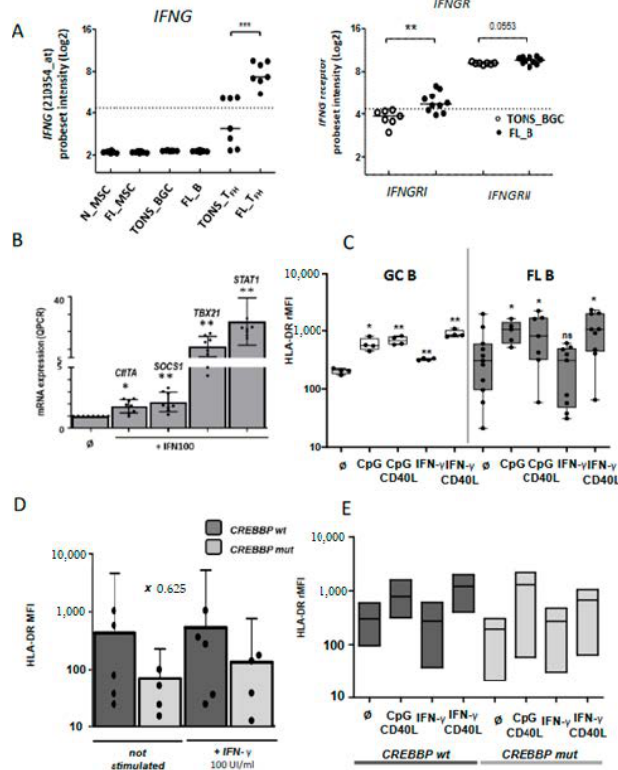
Figure 5. IFN- γ pathway in malignant B cells: ( A ) Up-regulation of IFNG (left panel) and IFNGR (right panel) mRNA expression on normal and FL subpopulations. ( B ) mRNA expression by qRT-PCR of IFN- γ -target genes ( CIITA, SOCS1, TBX21 and STAT1 ) in purified FL B cells stimulated or not ( Ǿ ) by IFN- γ 100 UI / mL (IFN100) for 24 h. ( C ) HLA-DR cell-surface expression on normal GC B cells (left panel) or FL B cells (right panel) cultivated for 24 h with CPG or IFN- γ , with or without CD40L stimulation, and according to CREBBP mutation. ( D and E ) rMFI: ratio of mean fluorescence intensity, wt: wild type, mut: mutation; Bars: mean. ns non-significant, * p < 0.05, ** p < 0.01, *** p < 0.001 compared to normal ( A ) or non-stimulated conditions ( B to E ).